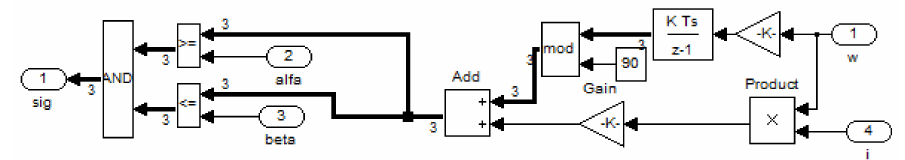
Figure 10. Rotor position detection module.